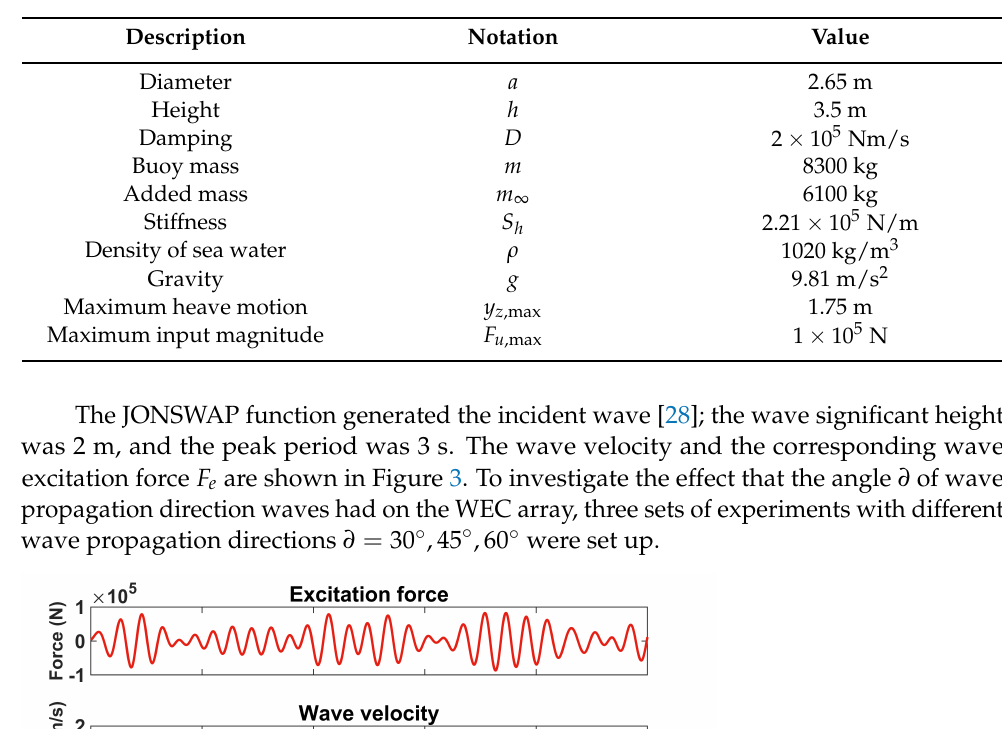
Table 2. Simulation parameters.